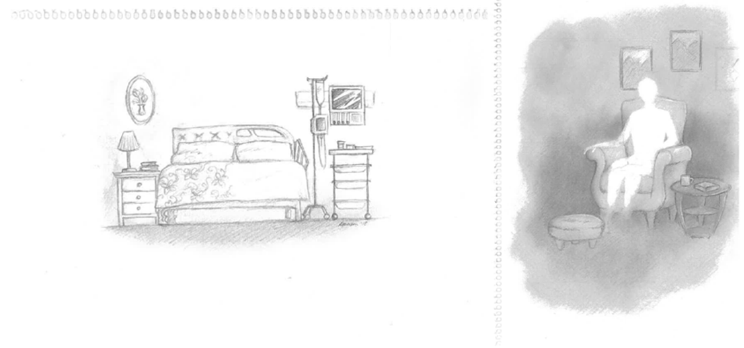
Figure 6. Professional photographs of carers, with their memoires.